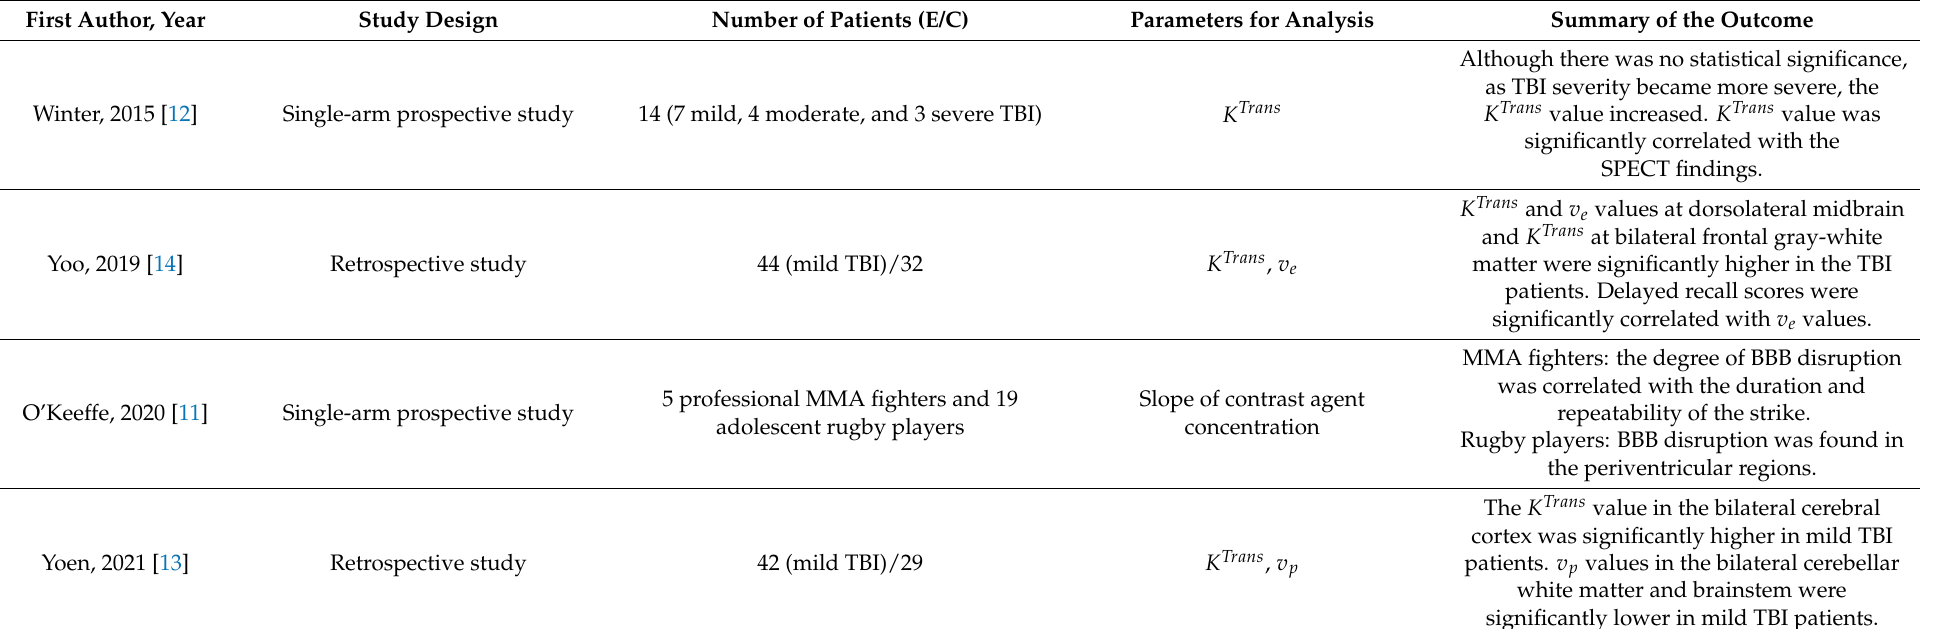
Table 1. Summary of the included